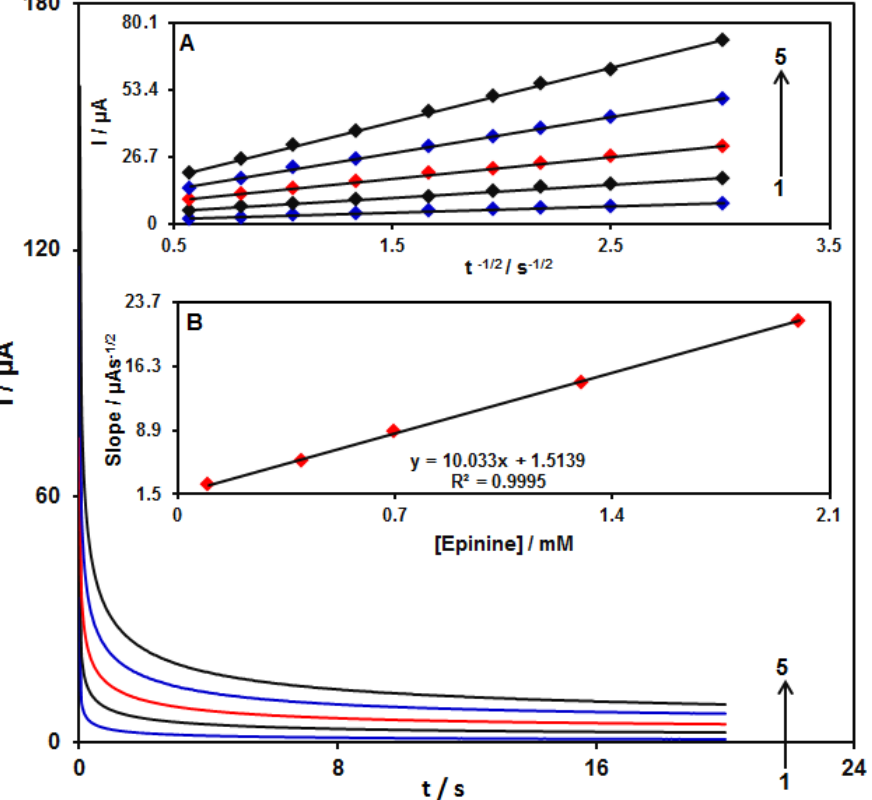
Figure 10. Chronoamperograms obtained at the GO/ZIF-67/SPE in 0.1 M PBS at pH of 7.0 for different concentrations of epinine. It is notable that numbers 1–5 correspond to 0.1, 0.4, 0.7, 1.3, and 2.0 mM of epinine. Inset ( A ) I versus t − 1/2 observed by chronoamperograms 1 to 5. ( B ) Slope plot of the straight line vs. the concentration of